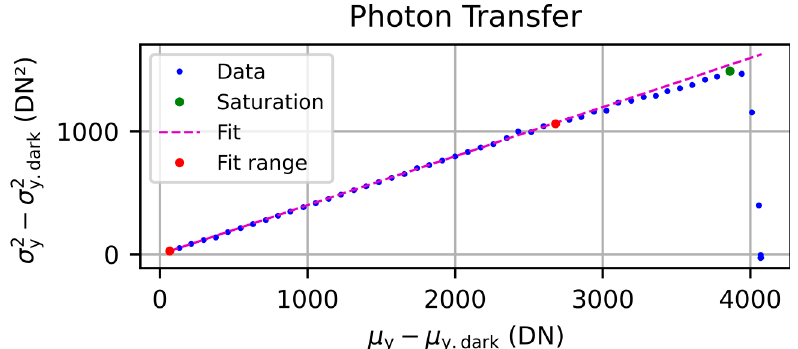
Figure A4. Photon transfer curve for the camera Allied Vision Mako G-419B NIR.